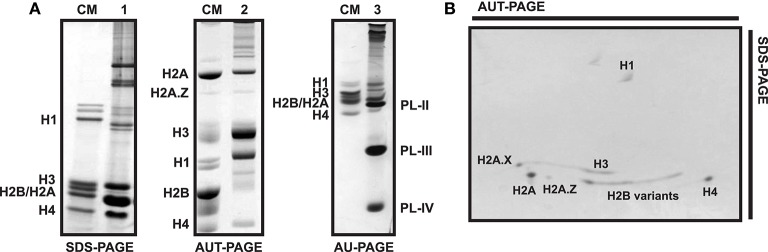
Electrophoretic profile of histone and SNBP proteins in different types of polyacrylamide gels. (A) SDS-PAGE (1) and AUT-PAGE (2) of male gonad from the variegated scallop Chlamys varia, AU-PAGE (3) of sperm from the mussel Mytilus. CM, chicken erythrocyte histones used as molecular marker. (B) Bi-dimensional PAGE from C. varia male gonad histone extract, being the first dimension an AUT gel and the second dimension an SDS gel. Bands corresponding to each histone or SNBP are indicated in the figures.